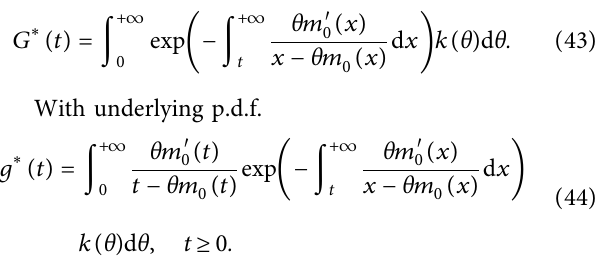
( t )) /ln ( G ( t )) in Example 3 for θ � 4/3 , 3/4 , 3/2 , θ 1